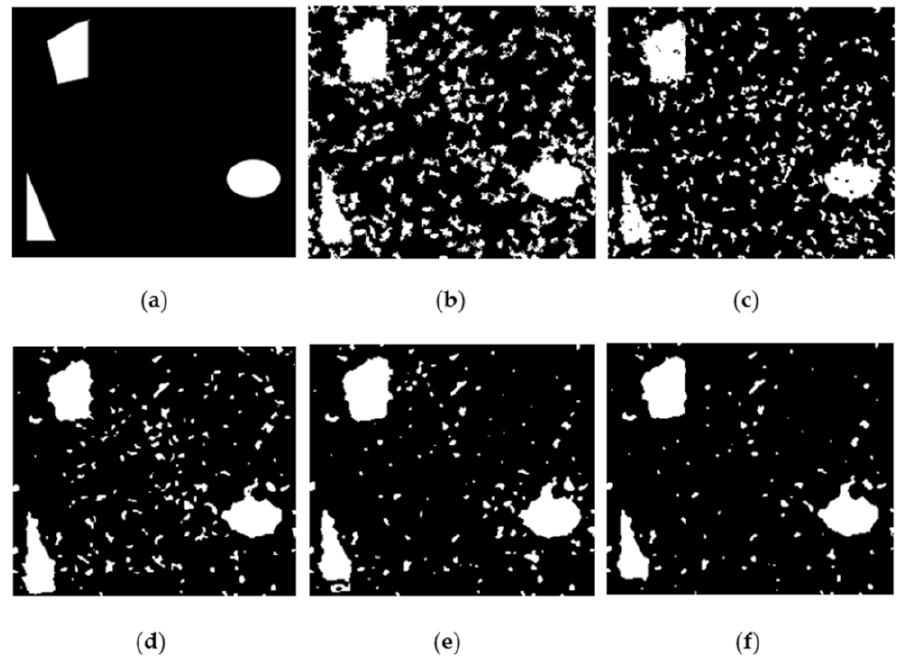
Figure 15. Change detection results on simulated SAR images. ( a ) Ground truth. ( b ) Result by Gabor- PCANet. ( c ) Result by NR-ELM. ( d ) Result by DBN. ( e ) Result by convolutional neural network (CNN). ( f ) Result by our proposed